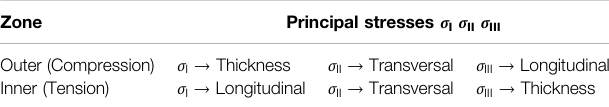
TABLE 4 | Alignment between principal stresses directions ( σ I , σ II , and σ III ) and orthotropic directions (Longitudinal, Transversal, and Thickness) in the shell- punch contact area produced by the effects of compressive stresses (outer surface) and tensile stresses (inner